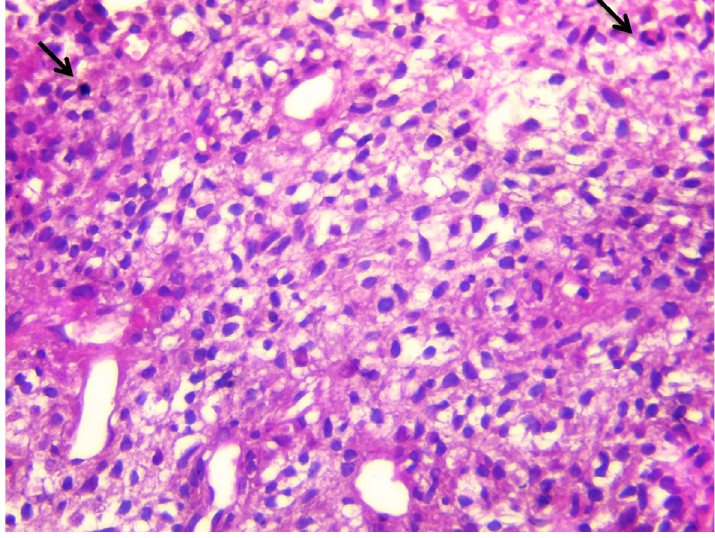
Figure 5. Mesenchymal pattern of a malignant phyllode tumor with a high stromal cellularity, nuclear atypia and mitosis (arrows) (HE stain (cid:1) 400).